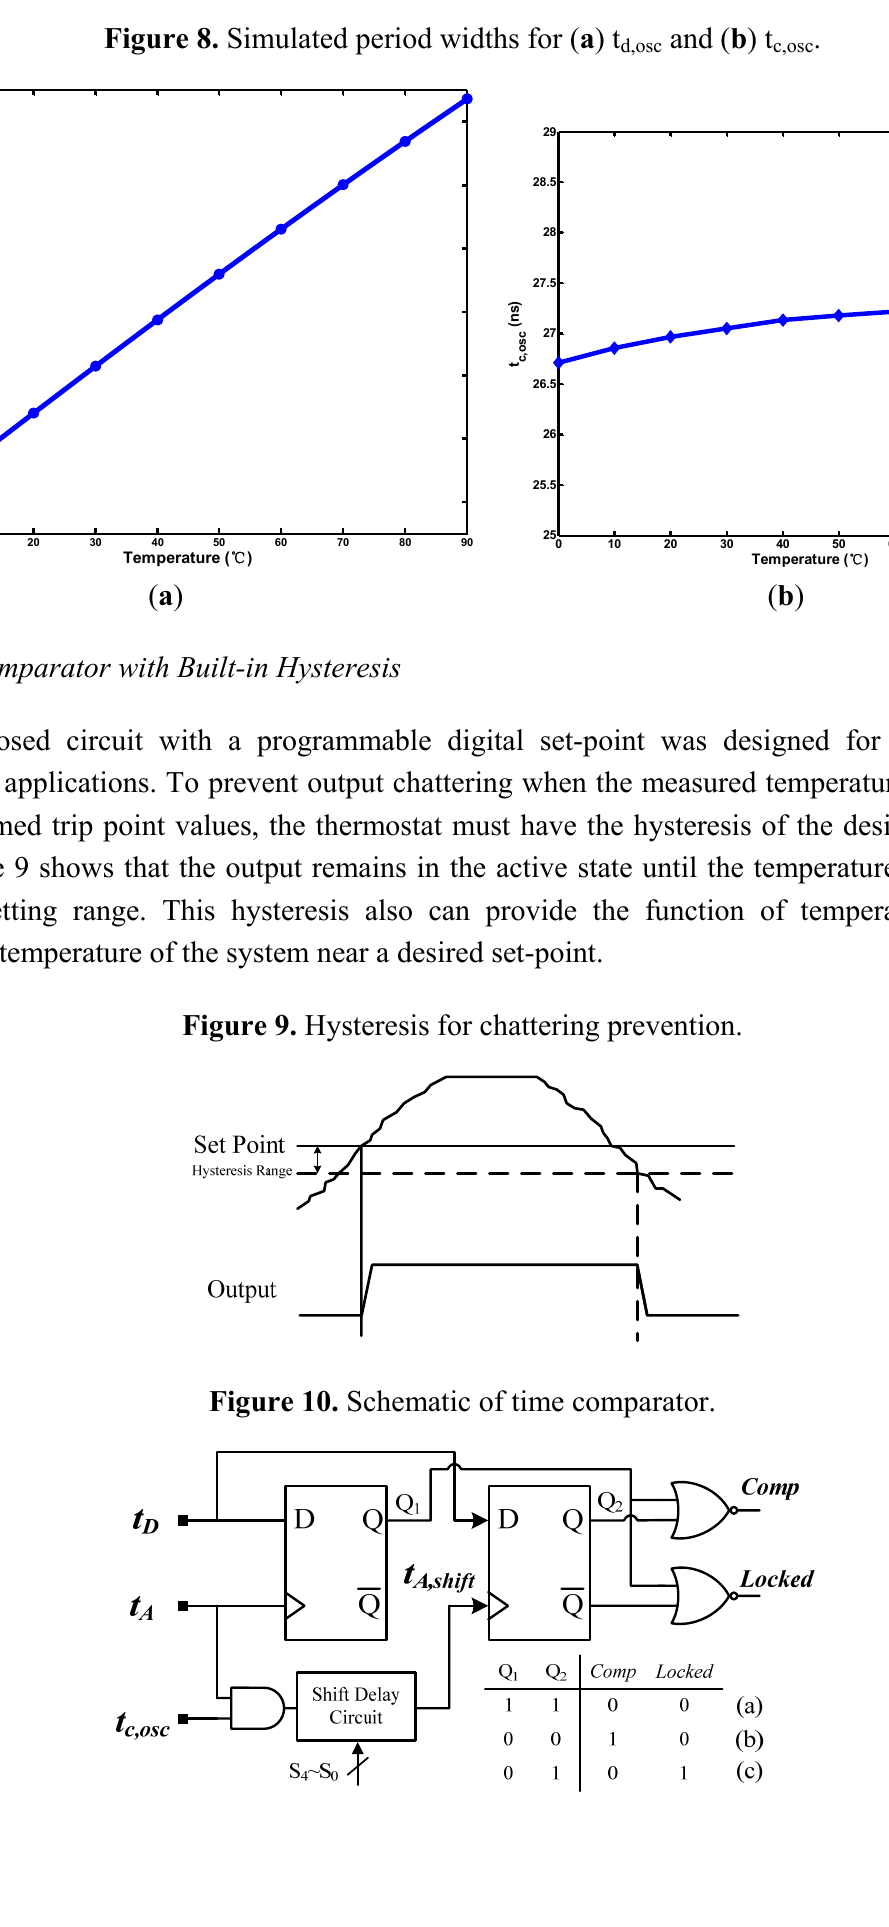
Figure 8. Simulated period widths for ( a ) t